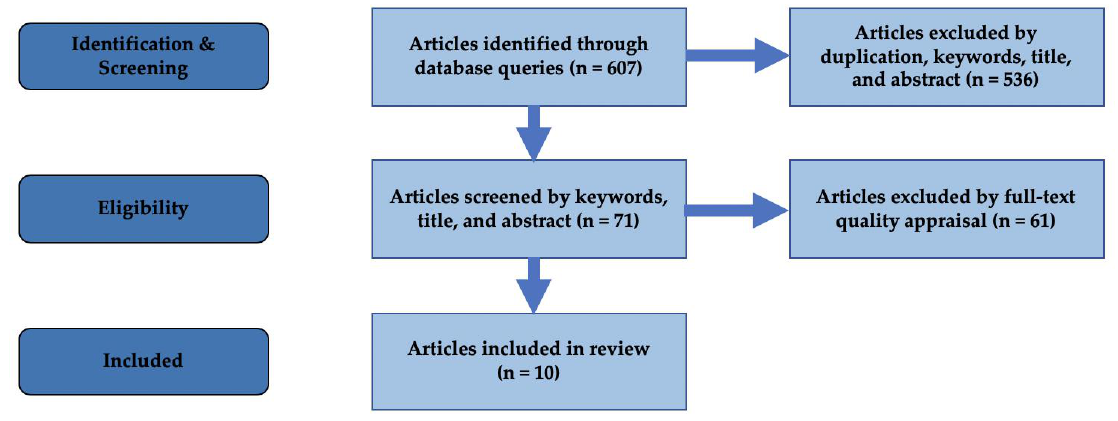
Figure 1. PRISMA flow diagram of review process.